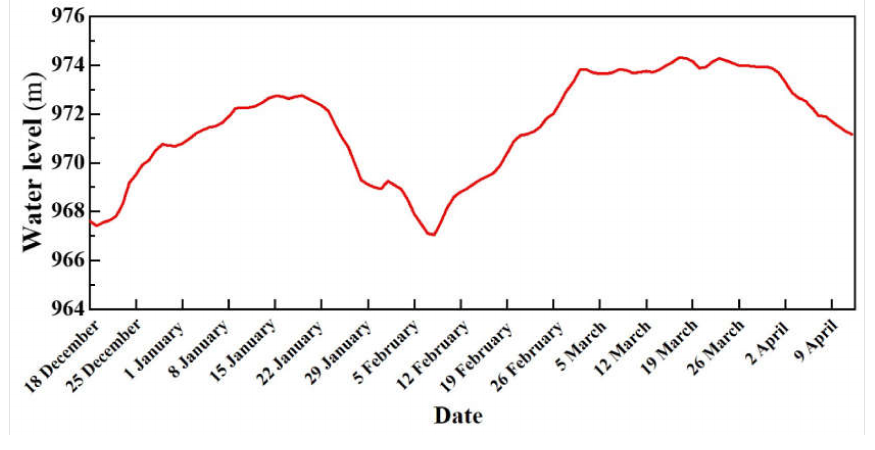
Figure 7. Water level in front of the Wudongde Dam.